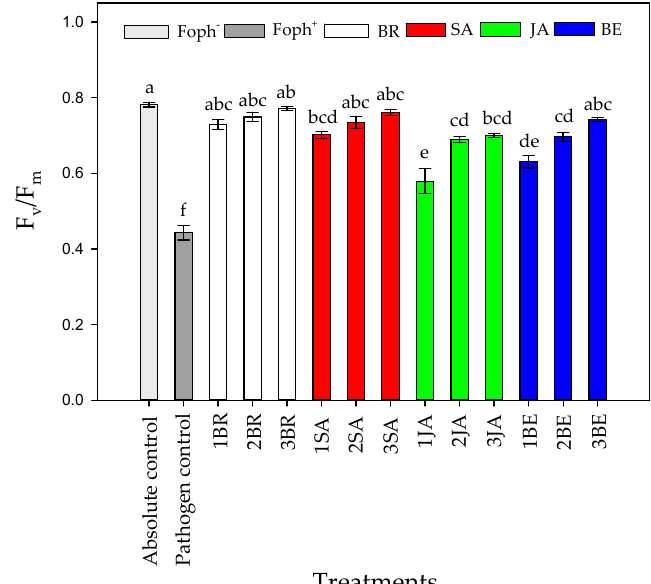
Figure 7. E ff ect of the di ff erent number of sprays (0, 1, 2 and 3 applications) of synthetic elicitors Figure 7. Effect of the different number of sprays (0, 1, 2 and 3 applications) of synthetic elicitors